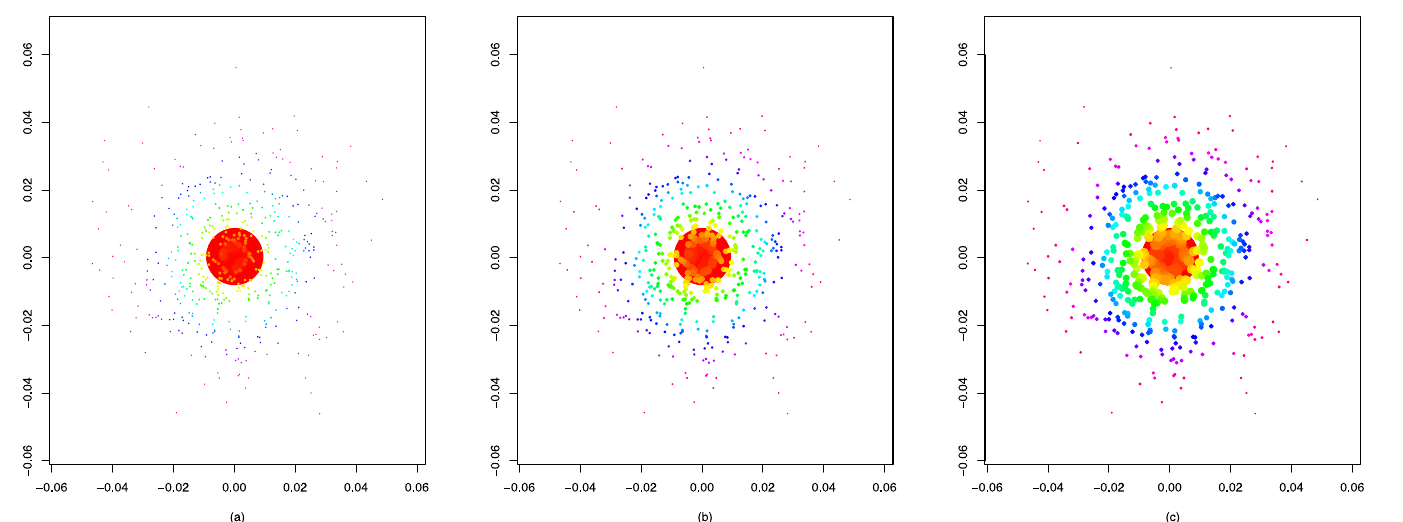
Fig 1. Latent positions scaled by a power-law γ with different θ . The radius of a circle indicates the value of γ i for the corresponding latent position. (a) θ = 1.7; (b) θ = 2.0; (c) θ = 2.3.